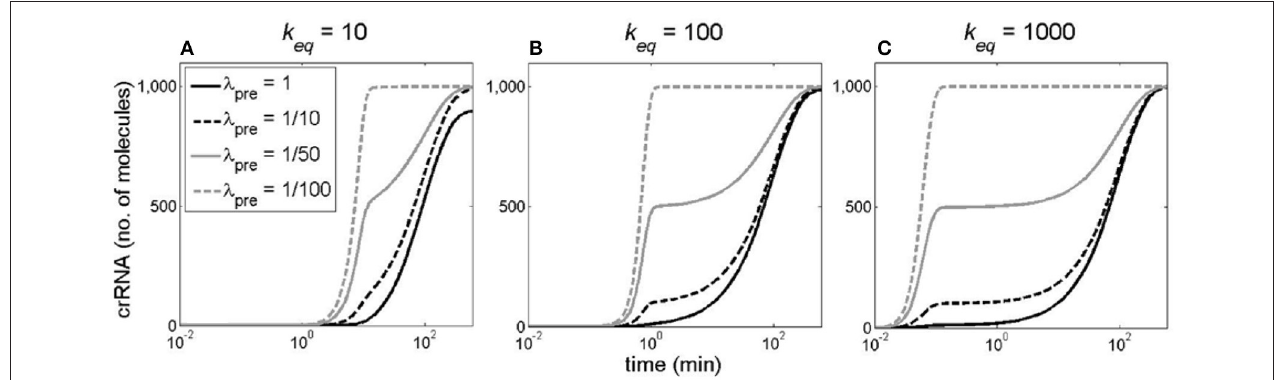
FIGURE 9 | The effect of perturbing pre-crRNA degradation rate on the dynamics of crRNA generation. The pre-crRNA processing rate increases to its equilibrium value through the cooperative model, while ϕ is held constant (at 10 1/min). Different curves correspond to different λ pre values: 1 (solid black), 1/10 (dashed black), 1/50 (solid gray), and 1/100 1/min (dashed gray). (A–C) , correspond to different k eq values indicated at the top of each